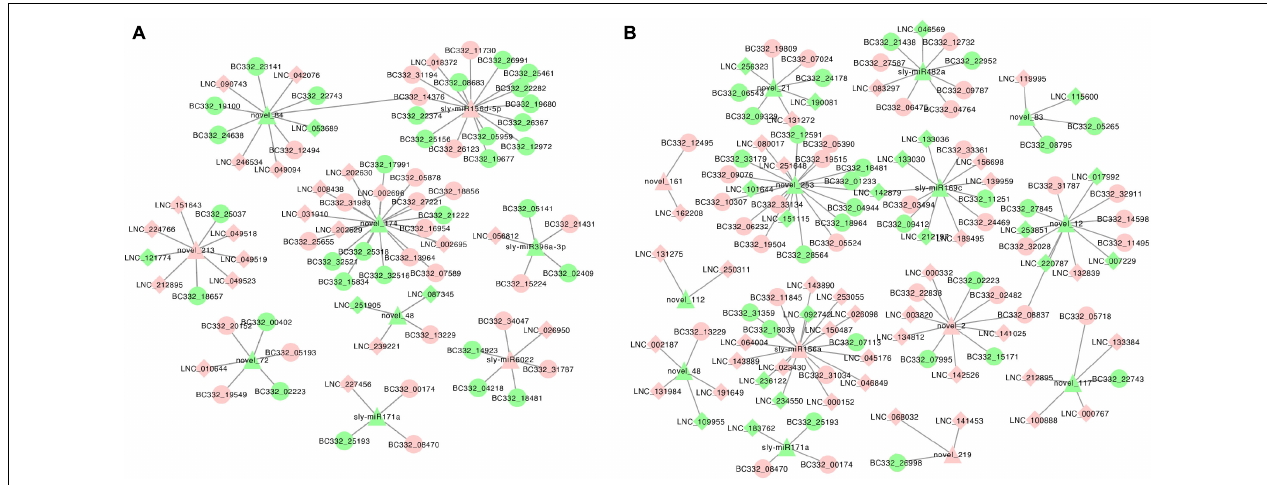
FIGURE 9 | The visualization of coexpression network in the hybrid and its parents. (A) lncRNA–miRNA–mRNA coexpression network between HNCy01 and HNCc22. (B) lncRNA–miRNA–mRNA coexpression network in HNCy01 vs. HNCc16. Red indicates upregulated, green indicates downregulated, ellipse indicates mRNA, diamond indicates lncRNA, and triangle indicates miRNA,